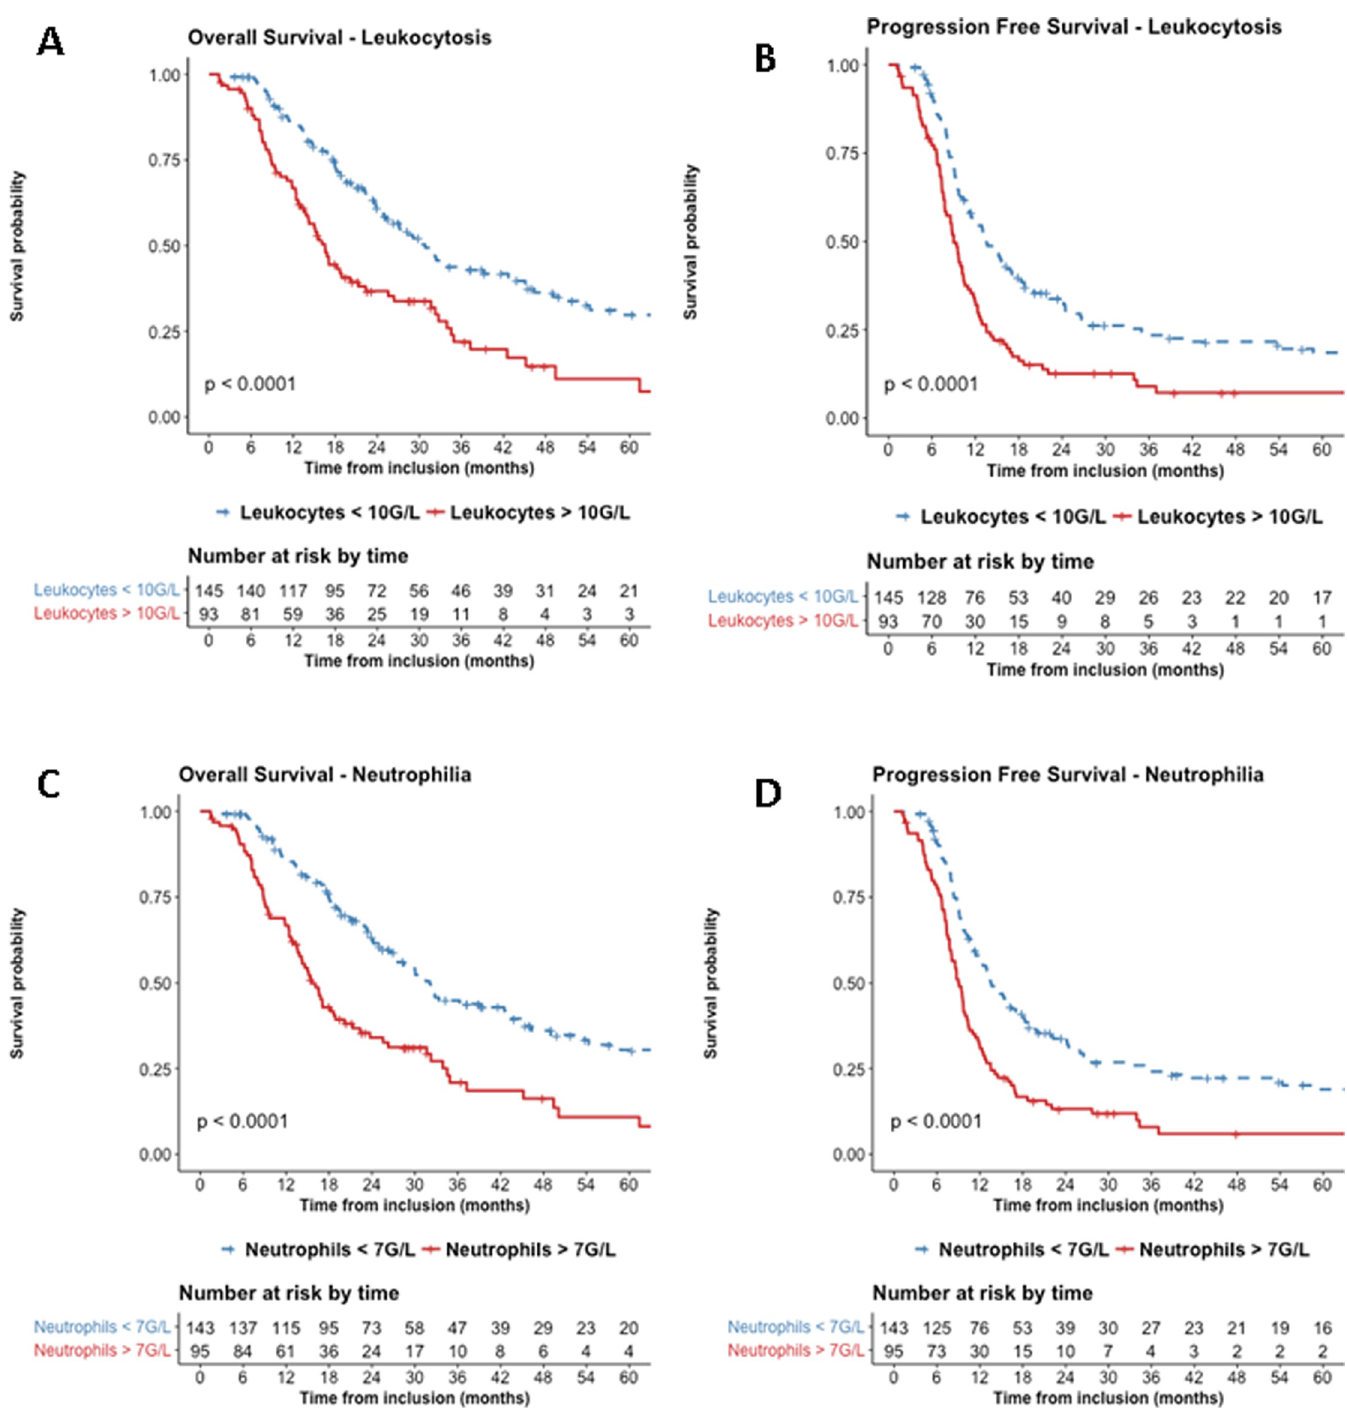
Fig 2. Estimated overall survival in patients with or without leukocytosis (A), progression free survival in patients with or without leukocytosis (B), overall survival in patients with or without neutrophilia (C) or progression free survival in patients with or without neutrophilia (D).